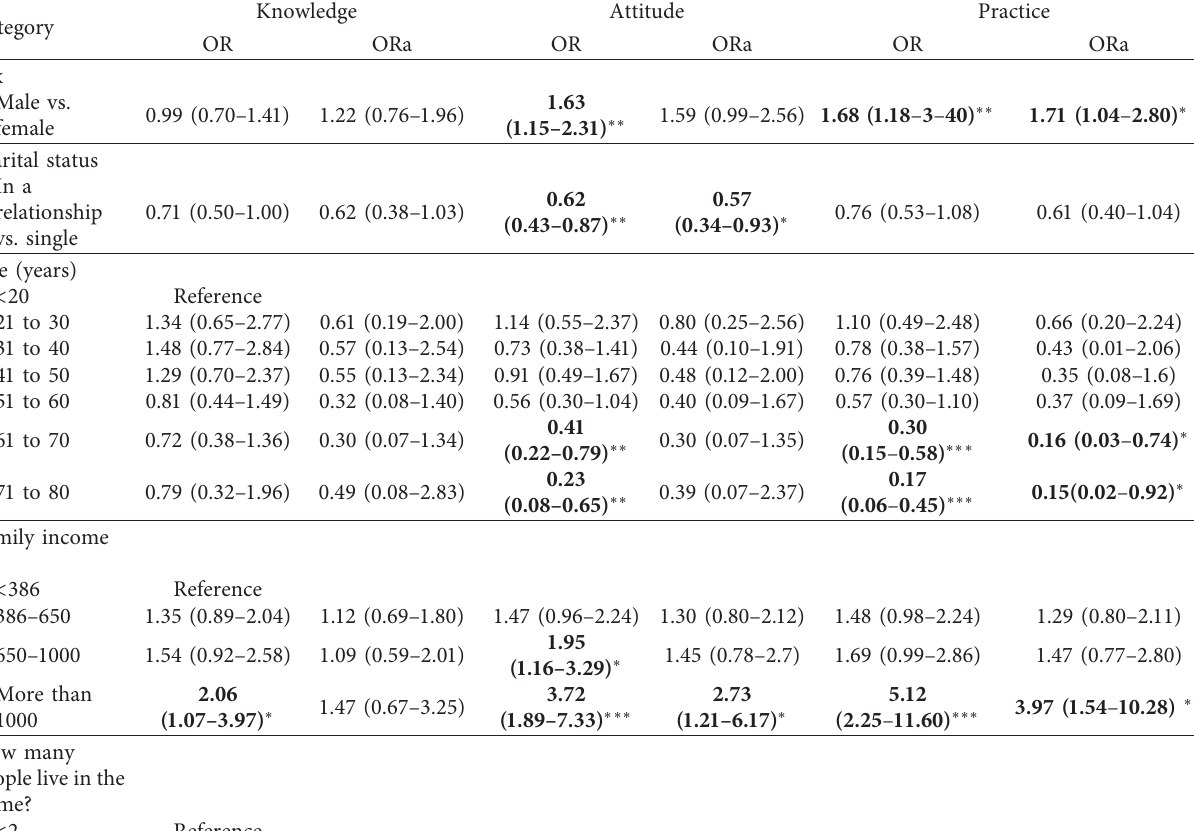
Table 4: Odds ratio (OR) and adjusted OR (ORa) for